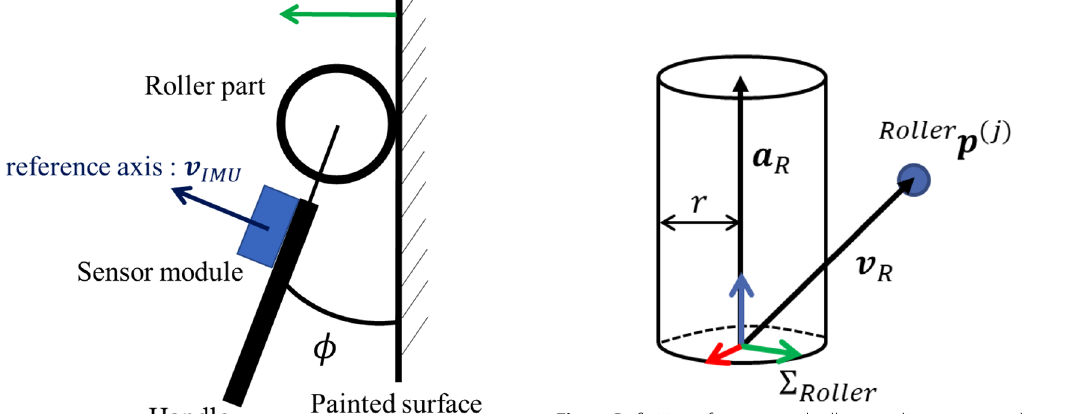
Fig. 7 Definition of vectors and roller coordinates. x, y, and z axes are shown by red, green and blue arrows,